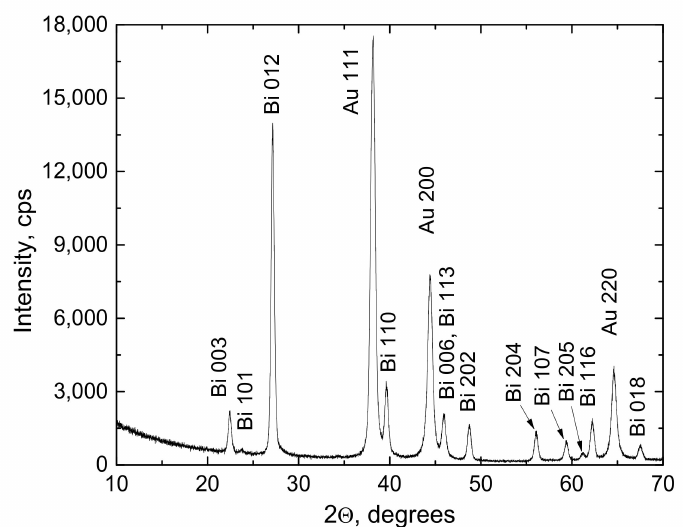
Figure 3. The XRD pattern of the electrodeposited 100 nm thick Bi film on Au substrate.